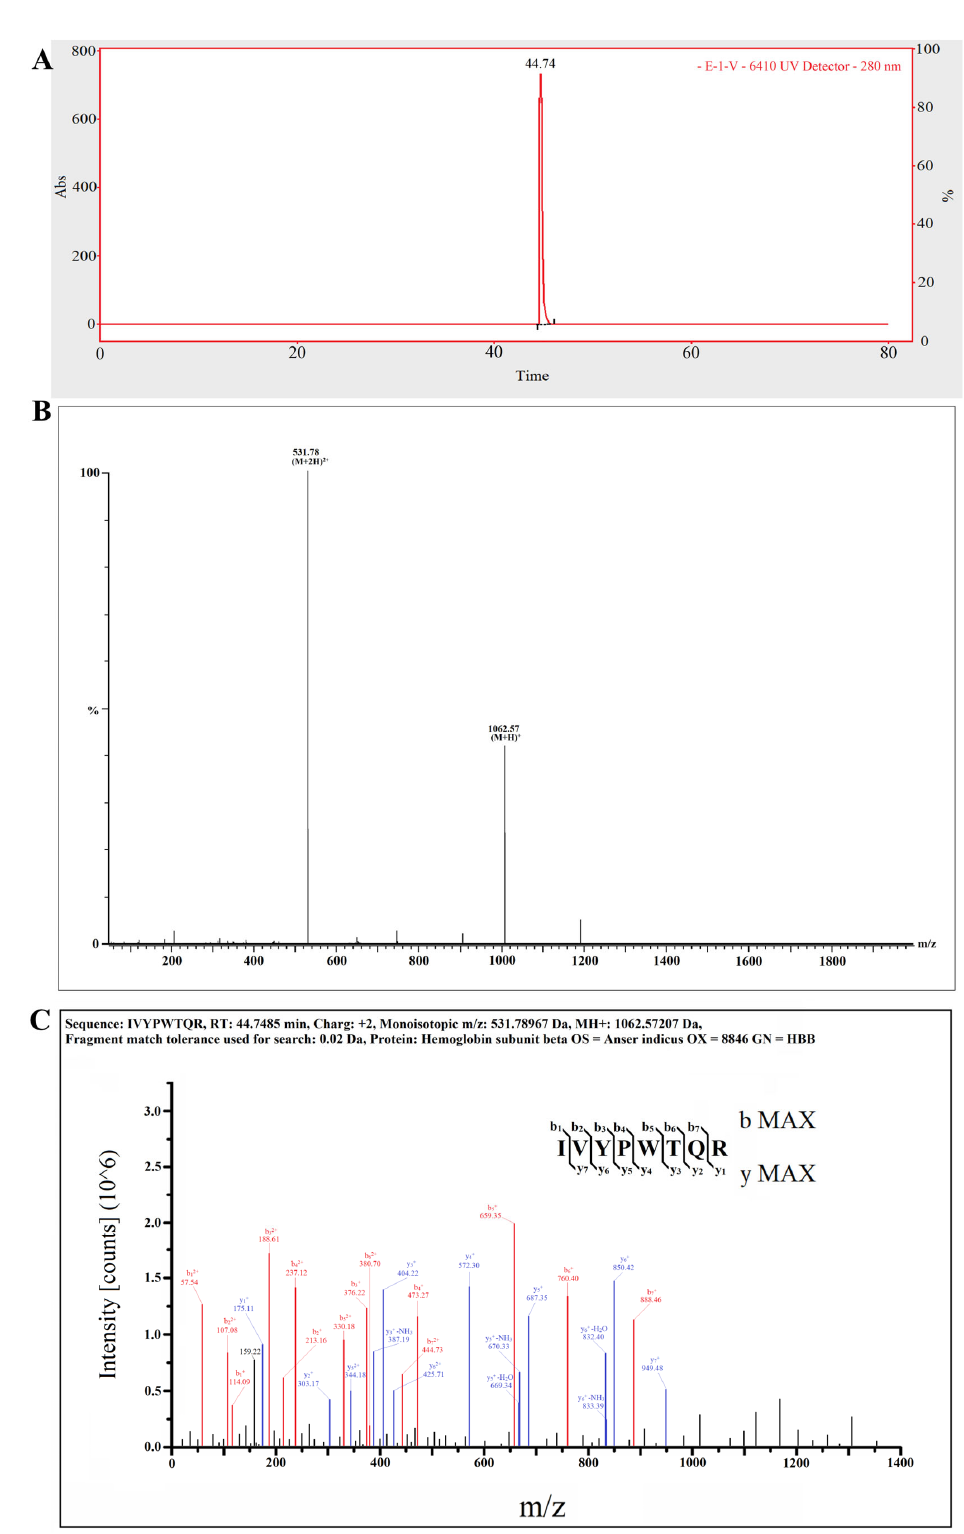
Figure 5. ( A ) The total particles of E − 1 − Ⅴ in MS/MS spectrum; ( B ) Mass spectrum of peak at 44.74 min; ( C ) Identification of the molecular weight and amino acid sequence of the purified E − 1 − Ⅴ by MS/MS spectrum.